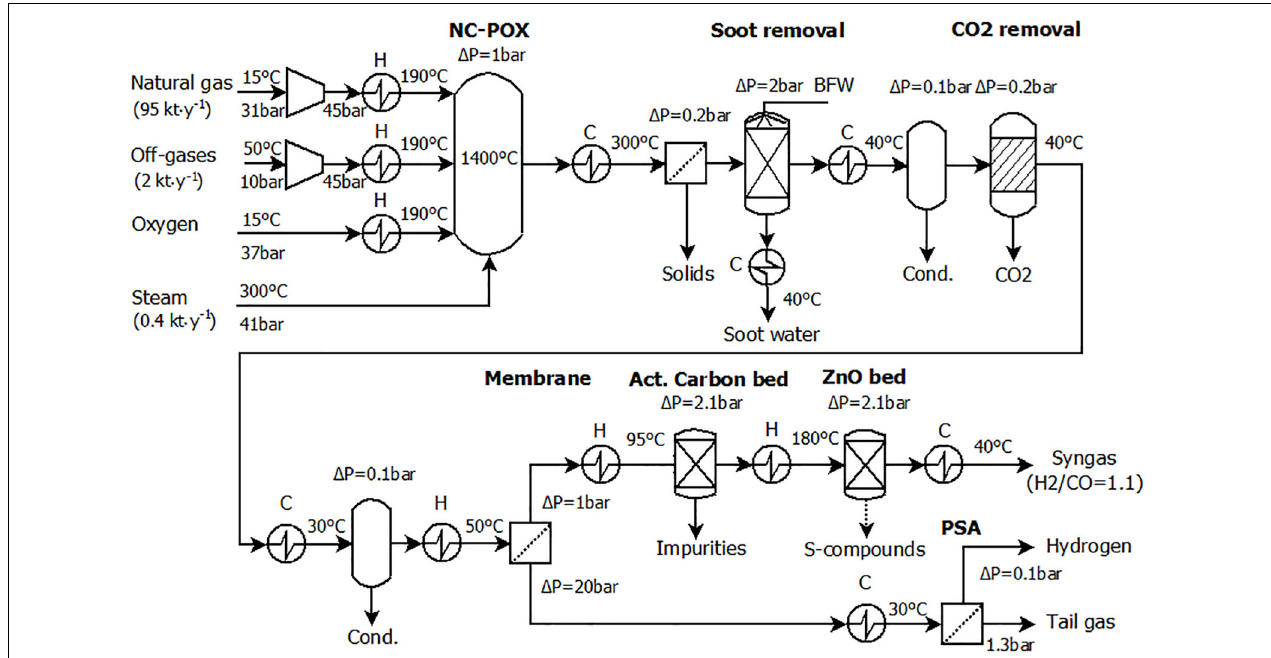
FIGURE 3 | Process scheme for the conventional syngas production. Reprinted with permission from Arvidsson et al. (2014). Copyright 2020 American Chemical